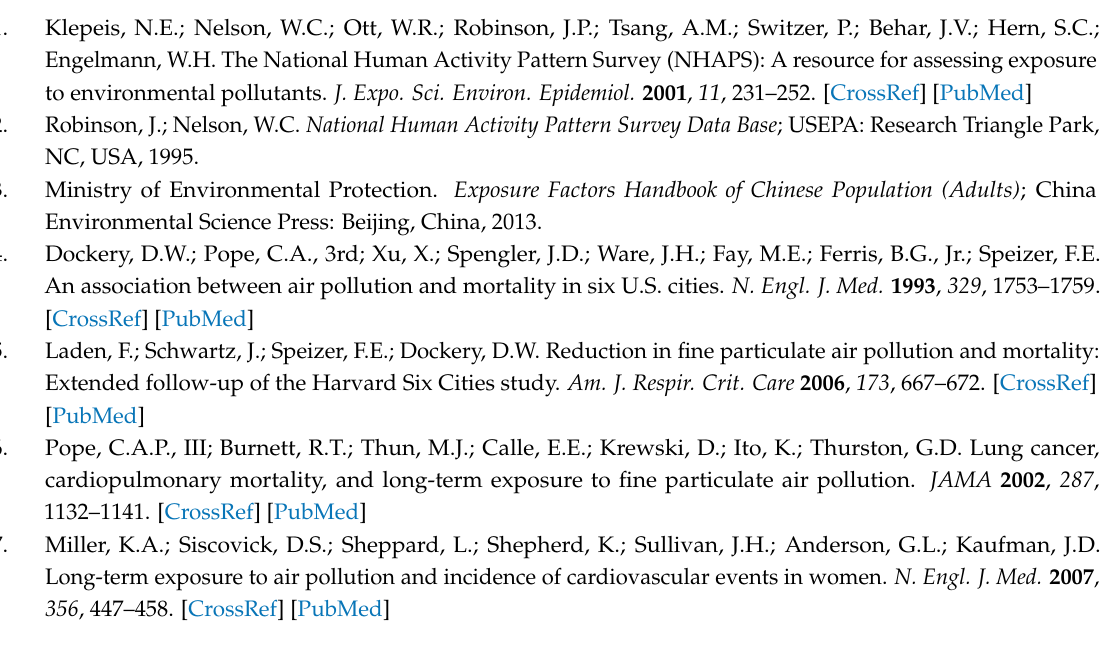
Table S1: Main summary of the baseline questionnaire and sampling questionnaire, Table S2: Summary of detection limits for chemical elements in this